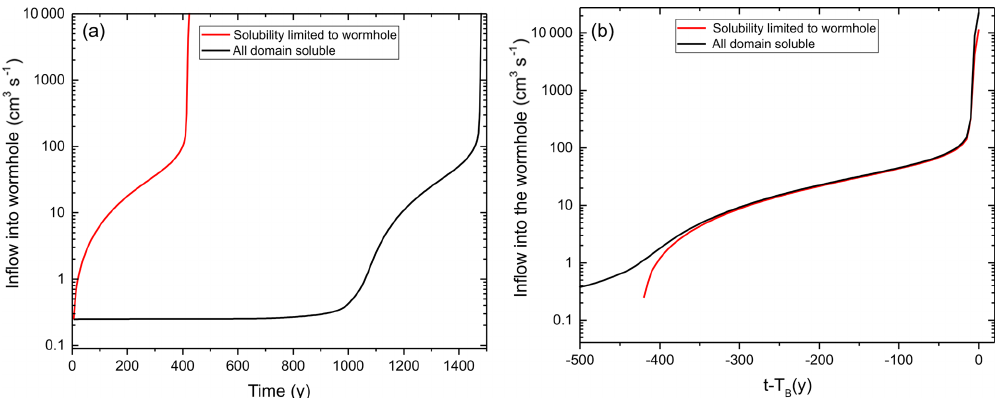
Figure 11. (a) Evolution of inflow into the wormhole for the case where solubility of fracture walls is limited to the position of wormhole (red line) and the case where the complete network is soluble (black line). (b) Same cases as in (a) , but the horizontal axis is defined as the time minus the breakthrough time for each case ( t − T B )